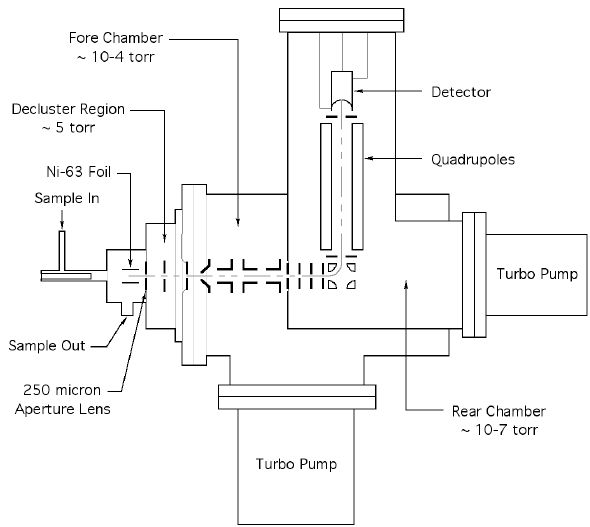
Fig. A2. APIMS vacuum system and ion optics, based on the Extrel molecular beam sampling system. Typical operating pressures are